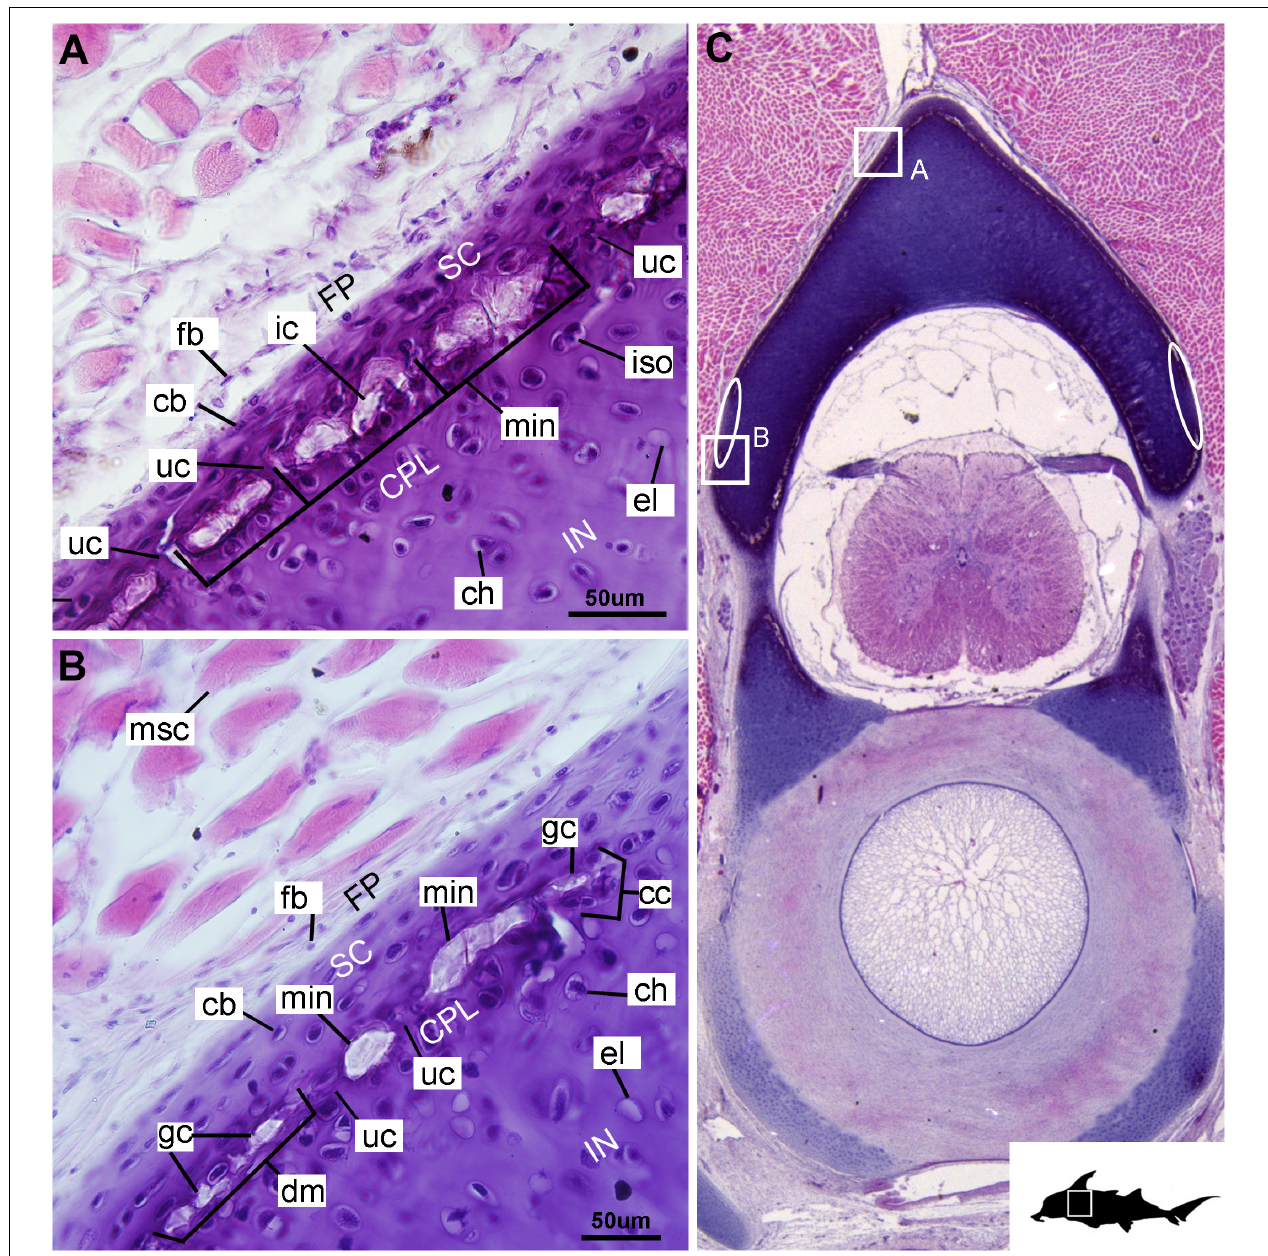
FIGURE 5 | Histological section through the posterior synarcual (anterior fused vertebrae) of a stage 36 embryo of Callorhinchus milii (Holocephali; Callorhinchidae). (A,B) Closeups showing perichondrium, cartilage, and mineralization in the neural arch; (C) overview of section with locations of closeup views indicated by white squares. Abbreviations: As in previous figures, also ellipses indicating areas not yet mineralized. Black silhouette of C. millii indicates approximate region shown in the